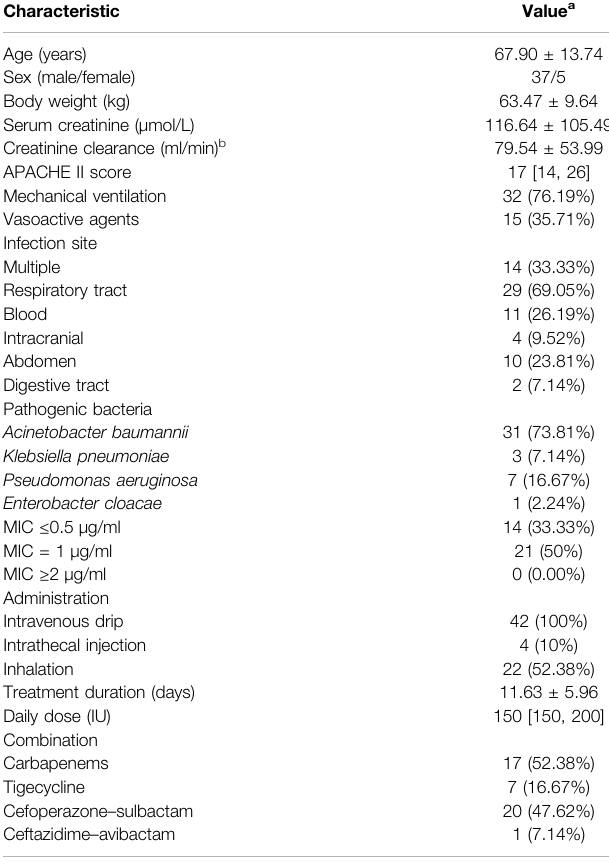
TABLE 1 | Clinical characteristics of